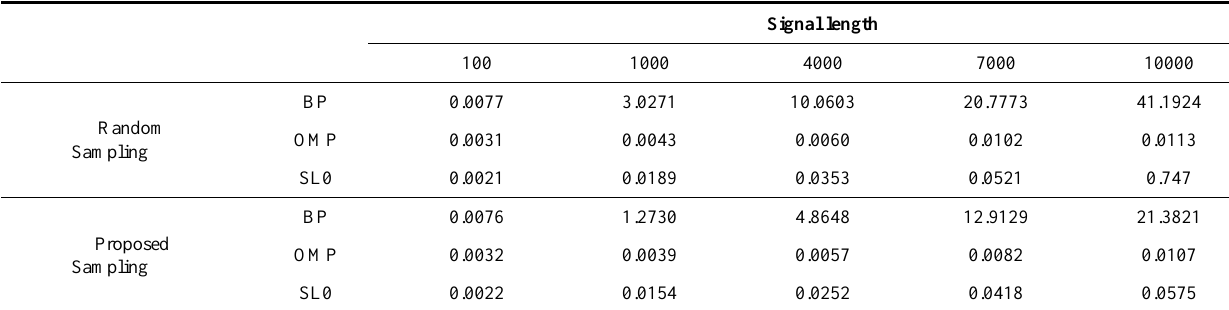
Table 1. Computation time (in second) per iteration for different methods for M =5